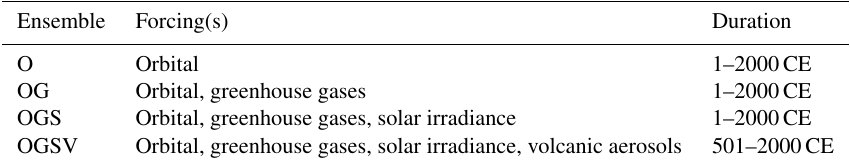
Table 2. The forcing(s) and duration for each ensemble of the CSIRO Mk3L model simulations. Ensemble